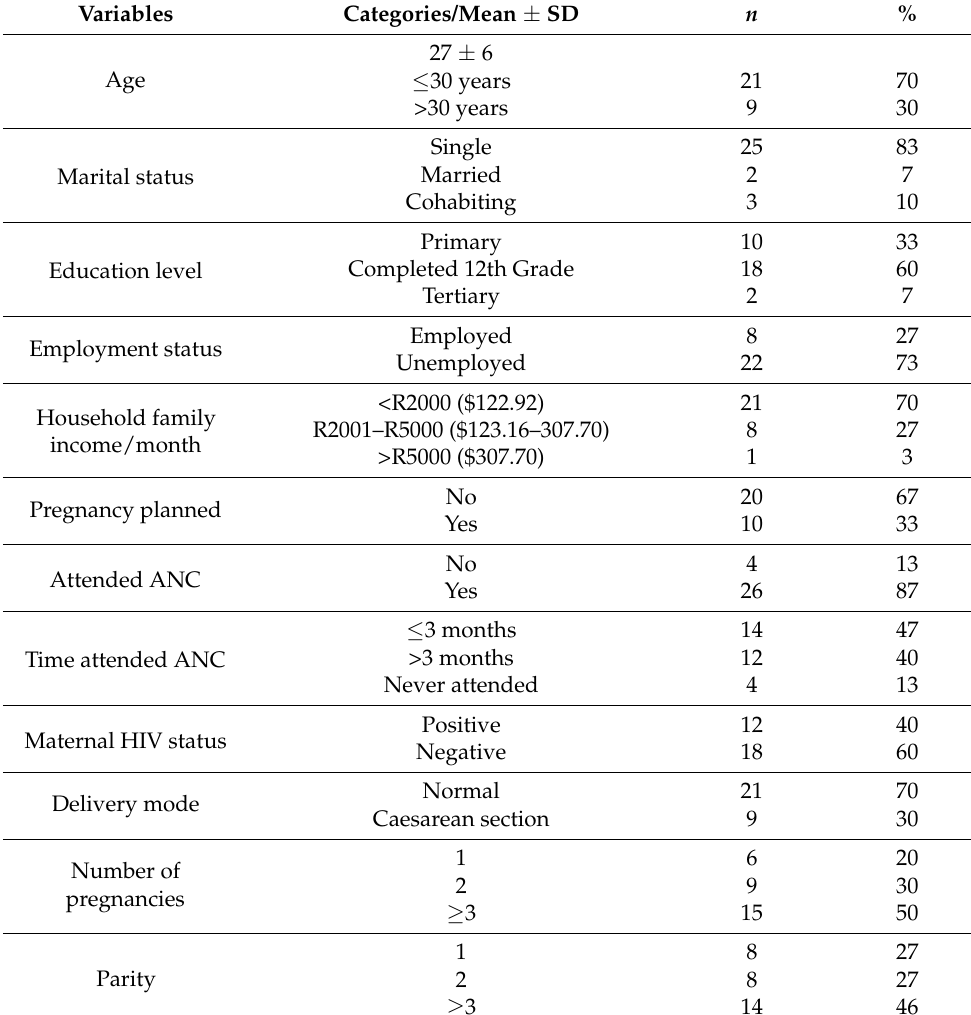
Table 1. Characteristics of mothers.